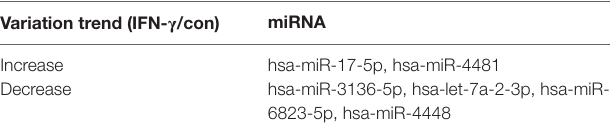
TaBle 2 | Differential miRNA expression in human corneal epithelial cells following IFN- γ